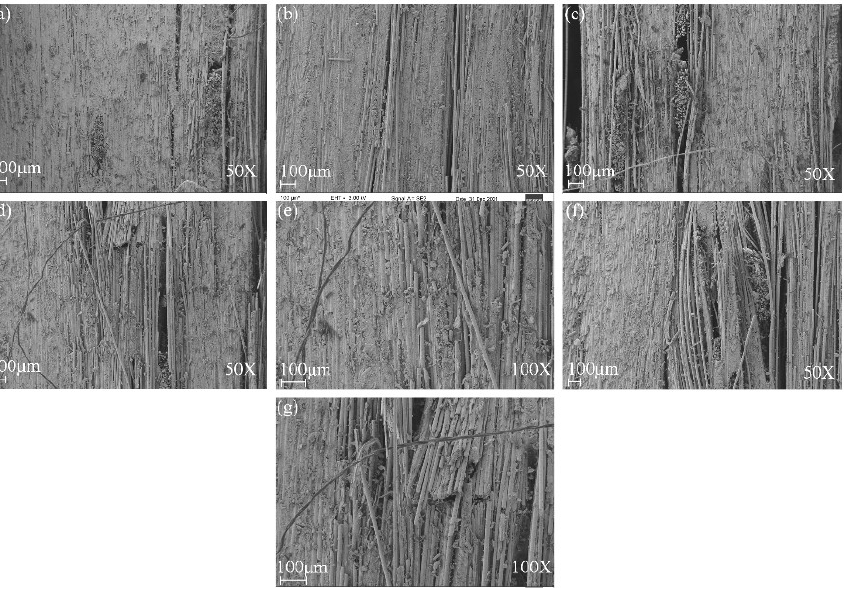
Figure 13. SEM images of impact specimens in dry condition ( a ) GF ( b ) BF ( c ) GB1 ( d ) GB2 ( e ) GB3 ( f ) GB4 ( g ) GB5.